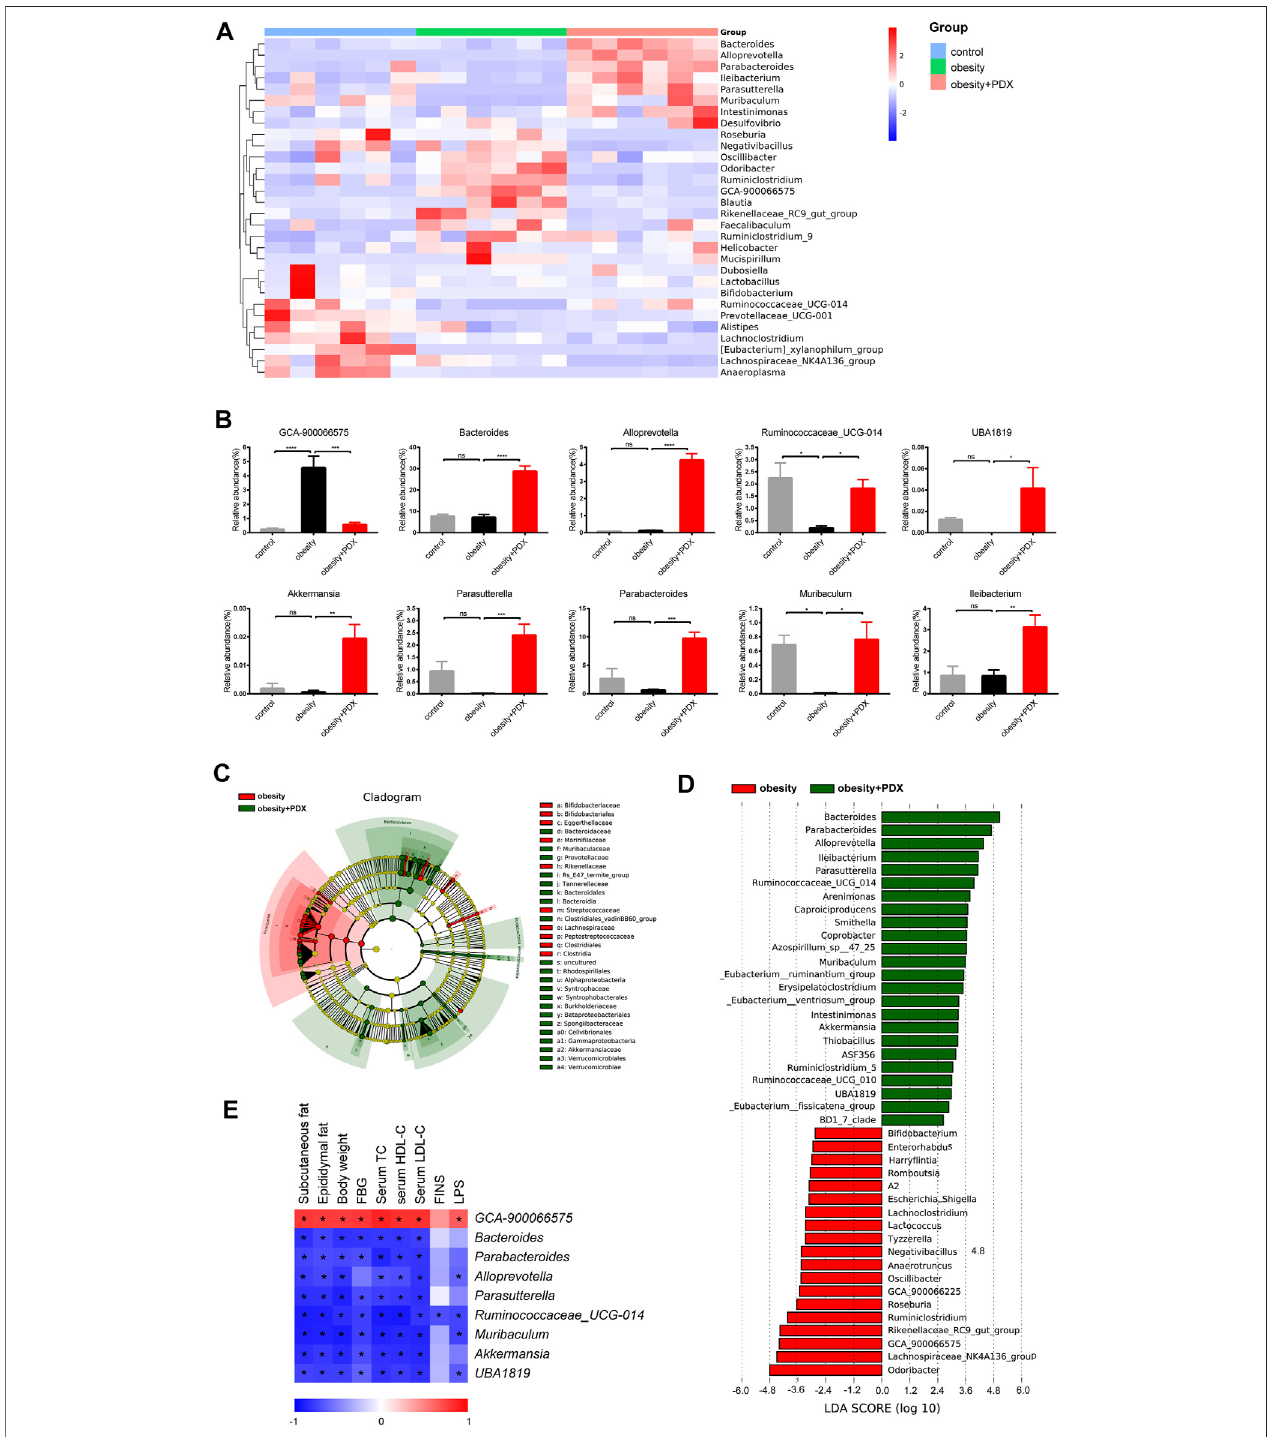
FIGURE 10 | PDX modulated the composition of gut microbiota at the genus level in HFD-induced obese mice (Part 2). (A) Heatmap analysis using taxonomic abundancesatthegenuslevel.Top30abundancesareshown. (B) Relativeabundanceof GCA-900066575,Bacteroides , Alloprevotella , Ruminococcaceae_UCG-014 , UBA 1819 , Akkermansia , Parasutterella , Parabacteroides , Muribaculum and Ileibacterium . (C) Cladogram derived from LEfSe analysis, showing the relationship between taxon. (D) Linear discriminant analysis (LDA) scores derived from LEfSe analysis, showing biomarker taxa at the genus level (LDA score > 2). (E) Heatmap analysis of the Spearman correlations between 9 genera and 9 metabolic parameters. n (cid:2) 6 per group. * p < 0.05; ** p < 0.01; *** p < 0.001; **** p < 0.0001; ns, not statistically signi fi cant.